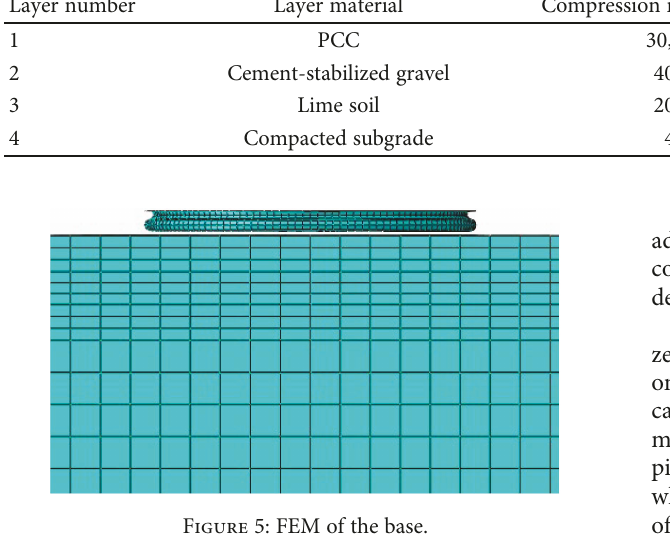
Figure 5: FEM of the base.